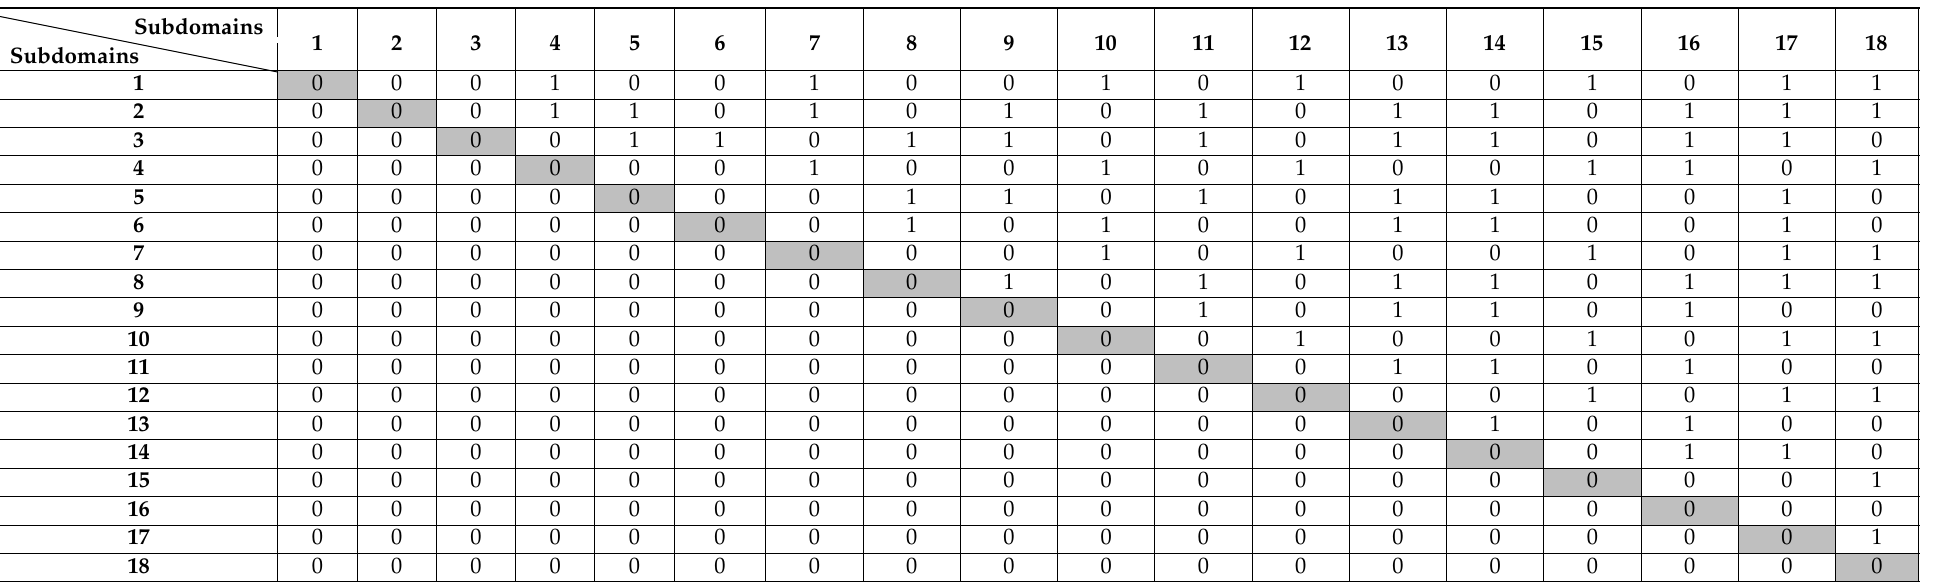
Table 18. Use-case Subdomains Relation Table (SRT) for CO 2 sensor